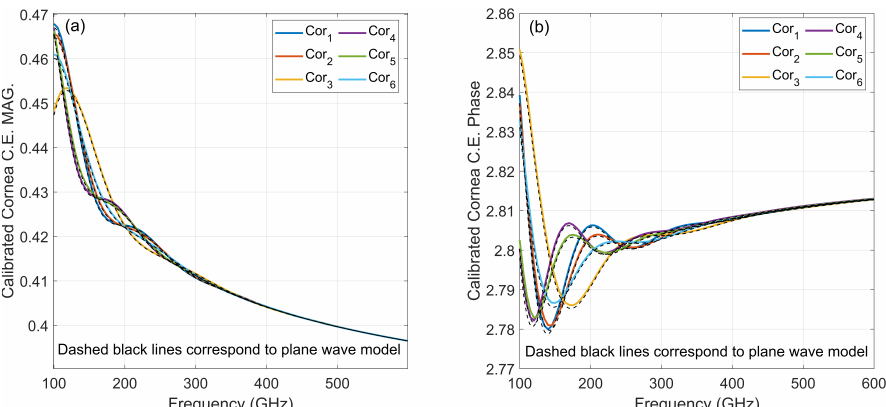
Figure 2. Correctly calibrated cornea coupling efficiency ( a ) magnitude and ( b ) phase are compared with stratified medium theory (shown in black-dashed line) at frequency range of 100–600